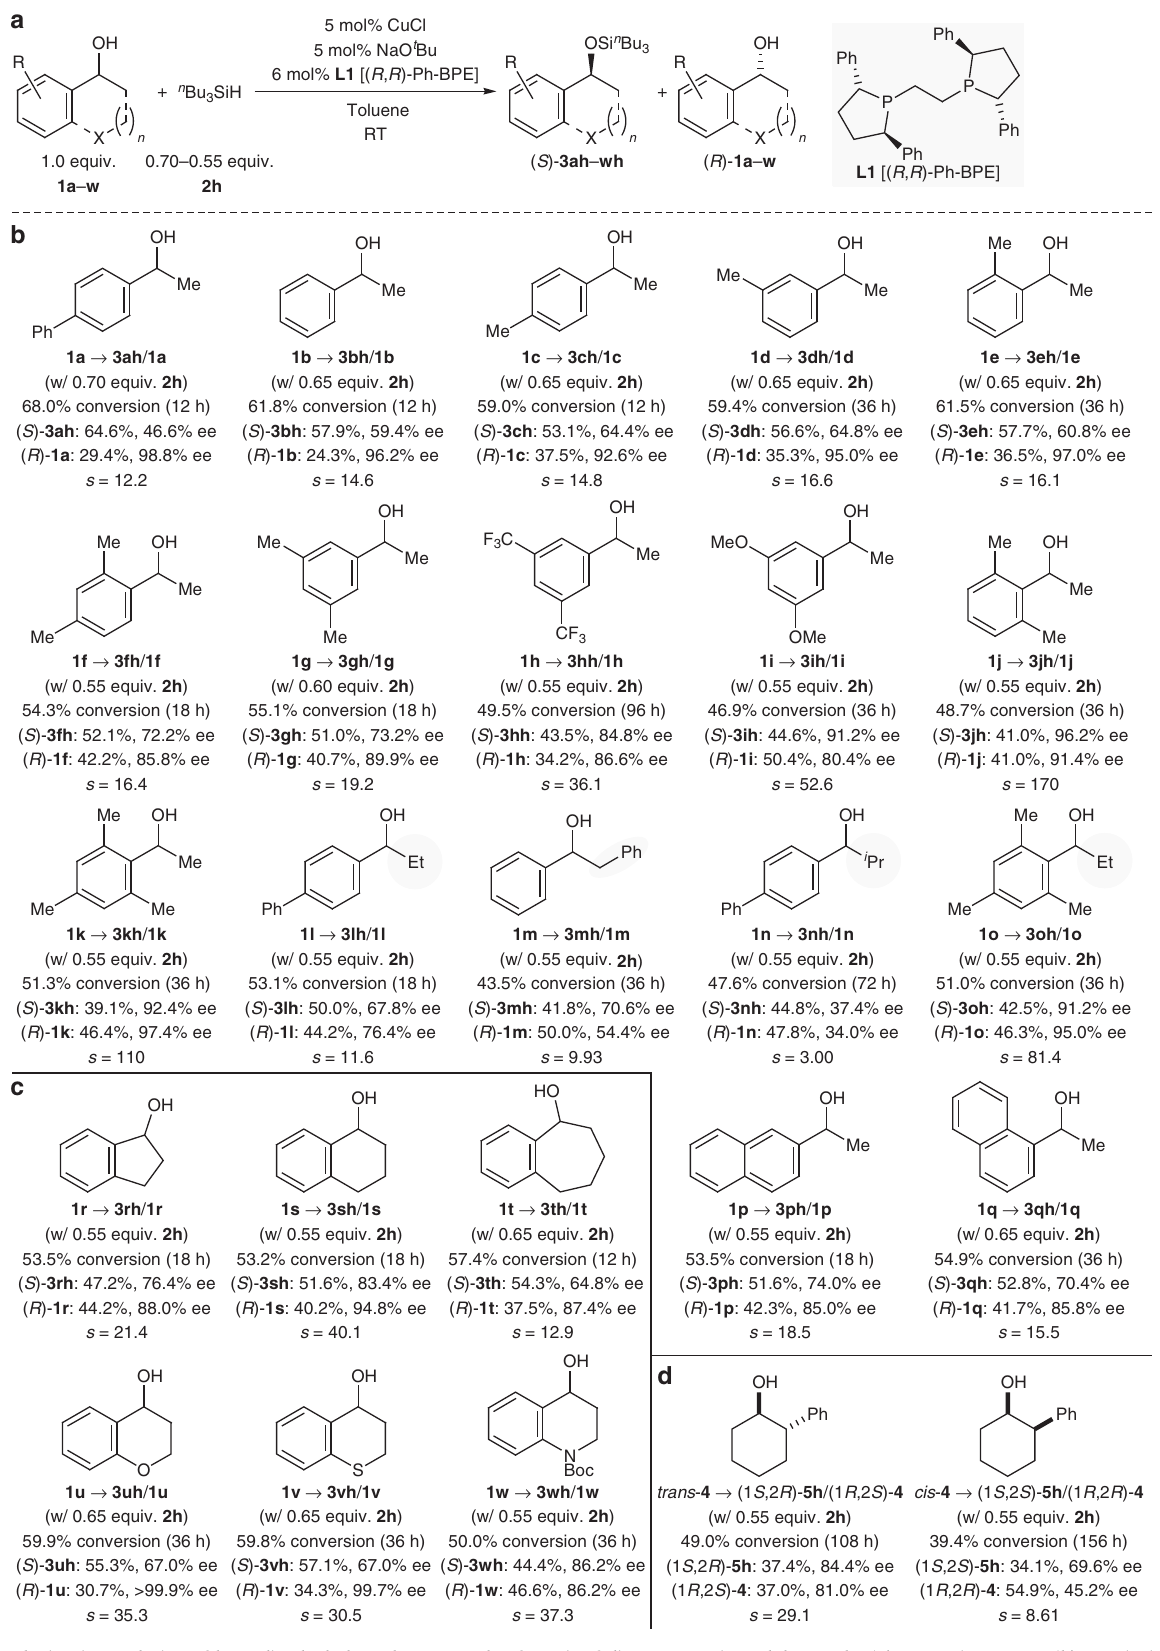
Figure 3 | Kinetic resolution of benzylic alcohols and an example of a pair of diastereomeric cyclohexanols. ( a ) General equation. ( b ) Acyclic benzylic alcohols. ( c ) Cyclic benzylic alcohols. ( d ) Diastereomeric